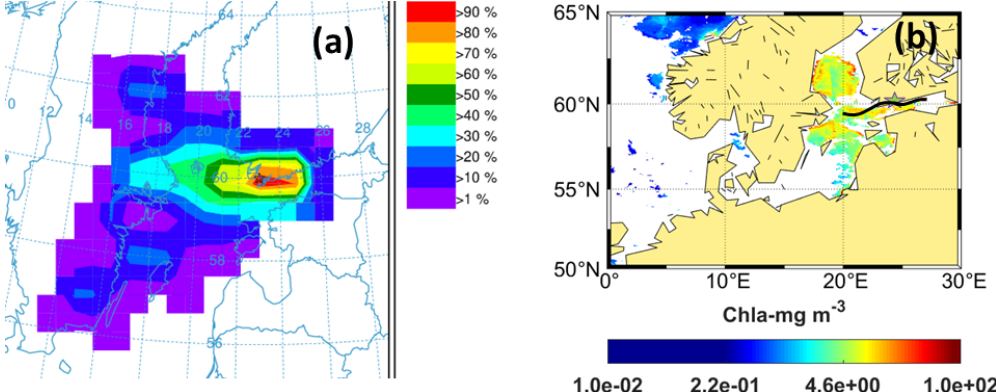
Figure 11. (a) Trajectory frequency plot (100ma.g.l., arrival time of trajectories at the measurement site: 22:00) for 24h back trajectory using GDAS meteorological input data (frequency grid resolution: 1 . 0 ◦ × 1 . 0 ◦ ). (b) Chl a concentrations (GlobColour level 3). Black line shows the trajectory direction, and the star point denotes the measurement